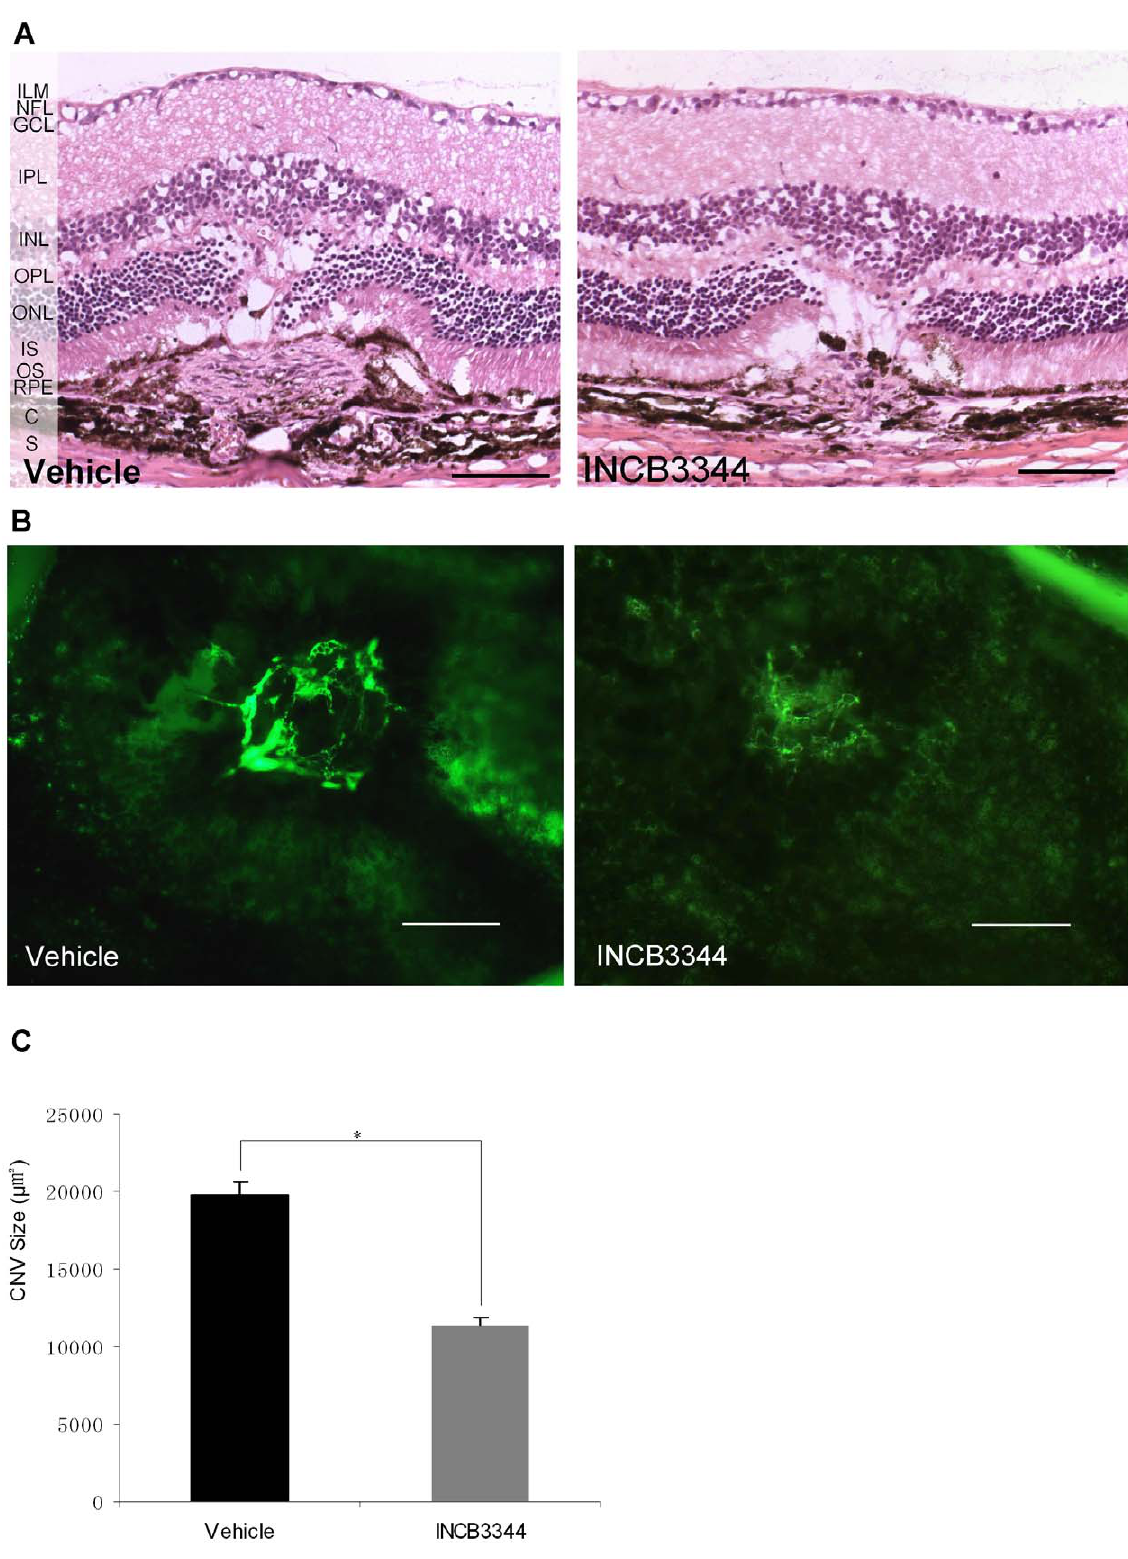
Figure 1. Effect of INCB3344 on CNV formation. ( A ) Haematoxylin–eosin-stained light micrograph of CNV lesions on Day 14 after laser photocoagulation. Each photograph shows the central area of CNV lesions in vehicle-treated or INCB3344-treated mice. Scale bar=100 m m. (ILM: internal limiting membrane; NFL: nerve fiber layer; GCL: ganglion cell layer; IPL: inner plexiform layer; INL: inner nuclear layer; OPL: outer plexiform layer; ONL: outer nuclear layer; IS: inner segment; OS: outer segment; RPE: retinal pigment epithelium; C: choroid; S: sclera). ( B ) Representative micrographs of CNV lesions in the choroid-RPE flat mounts from laser-induced CNV in mice treated with vehicle or INCB3344. CNV areas were